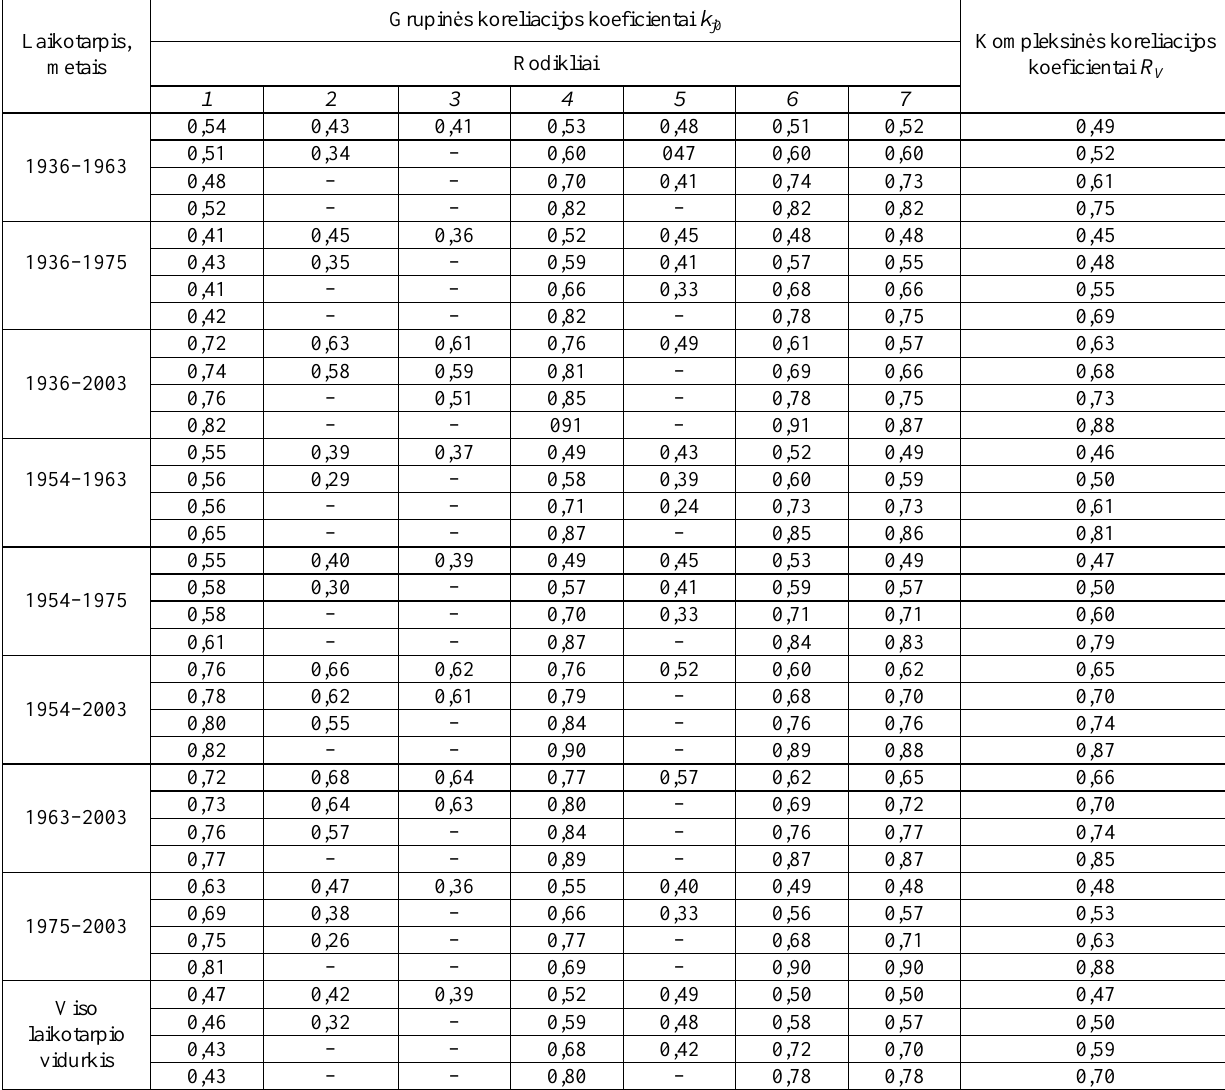
Table 2. Vertical Earth surface movement and geological, geomorphologic factors, group and average complex correlation